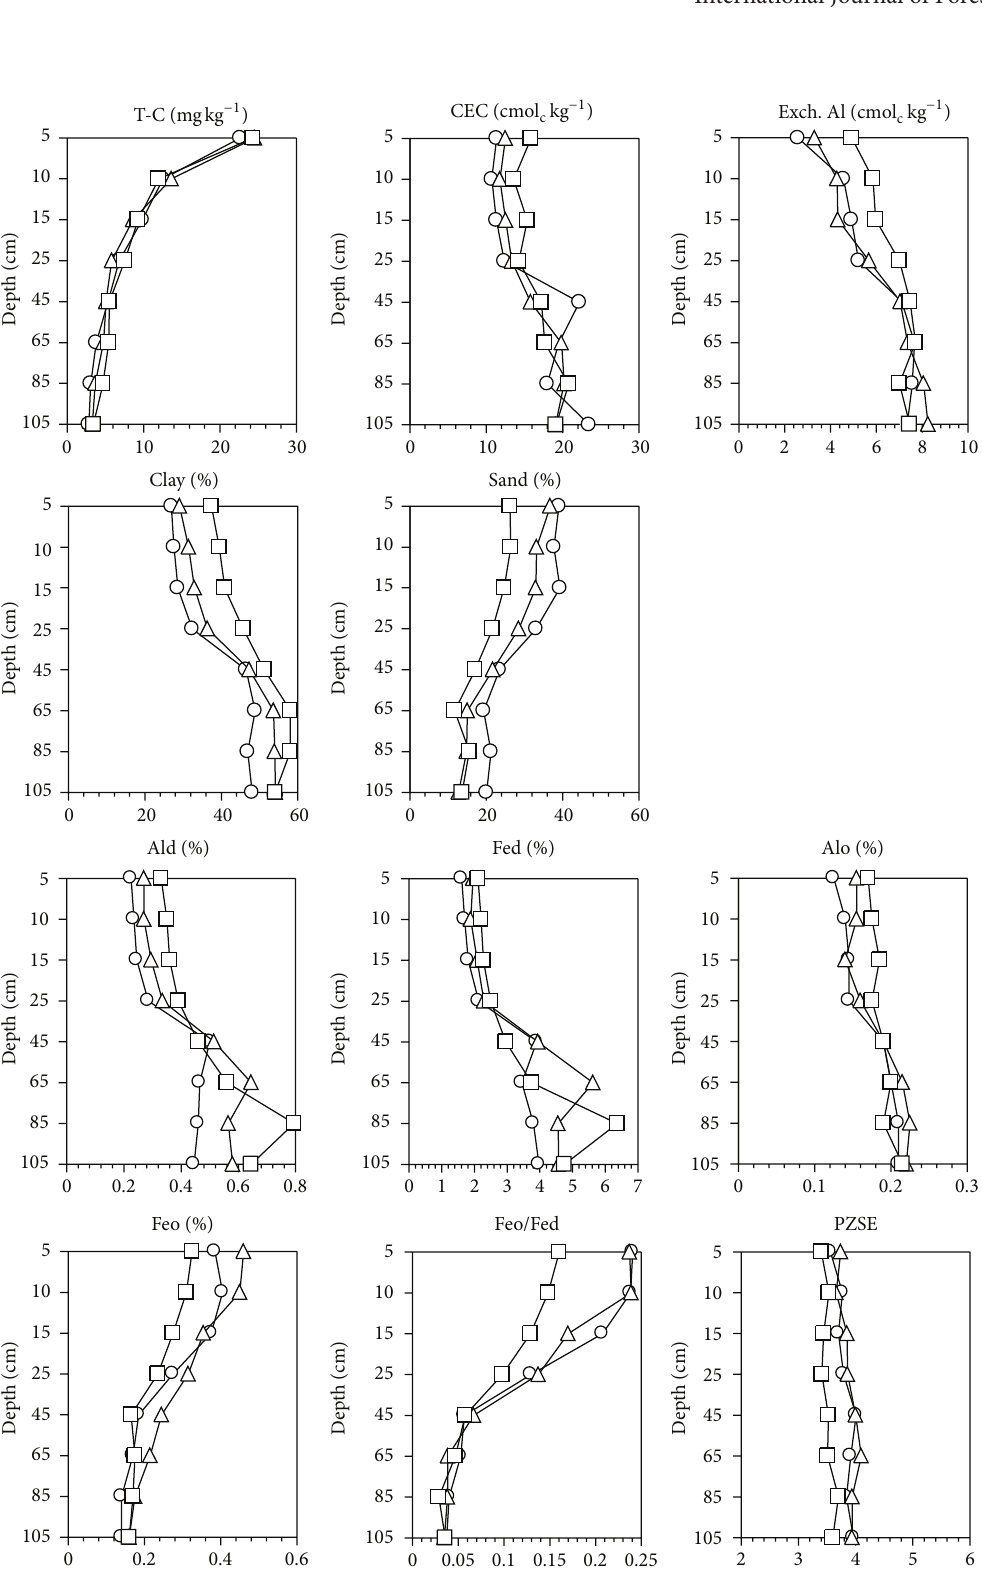
Figure 2: Vertical distribution of soil properties in the grassland, secondary forest, and logged forest in 2000; I : grassland, 󳵻 : secondary forest, ◻ : logged forest. T-C: total carbon; CEC: cation exchange capacity; Exch. Al, exchangeable aluminium; Ald and Fed: Al and Fe contents extracted by dithionite-citrate; Alo and Feo: Al and Fe contents extracted by ammonium oxalate; PZSE: point of zero salt